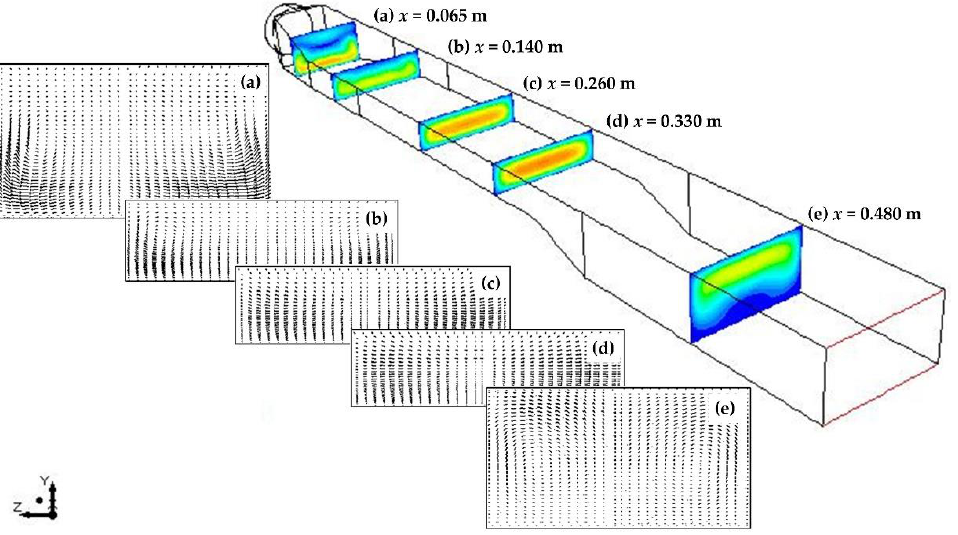
Figure 8. The cross-sectional velocity field along the axial direction at positions of ( a ) x = 0.065 m, ( b ) x = 0.140 m, ( c ) x = 0.260 m, ( d ) x = 0.330 m and ( e ) x = 0.480 m in MOCVD reactor at 673 K.